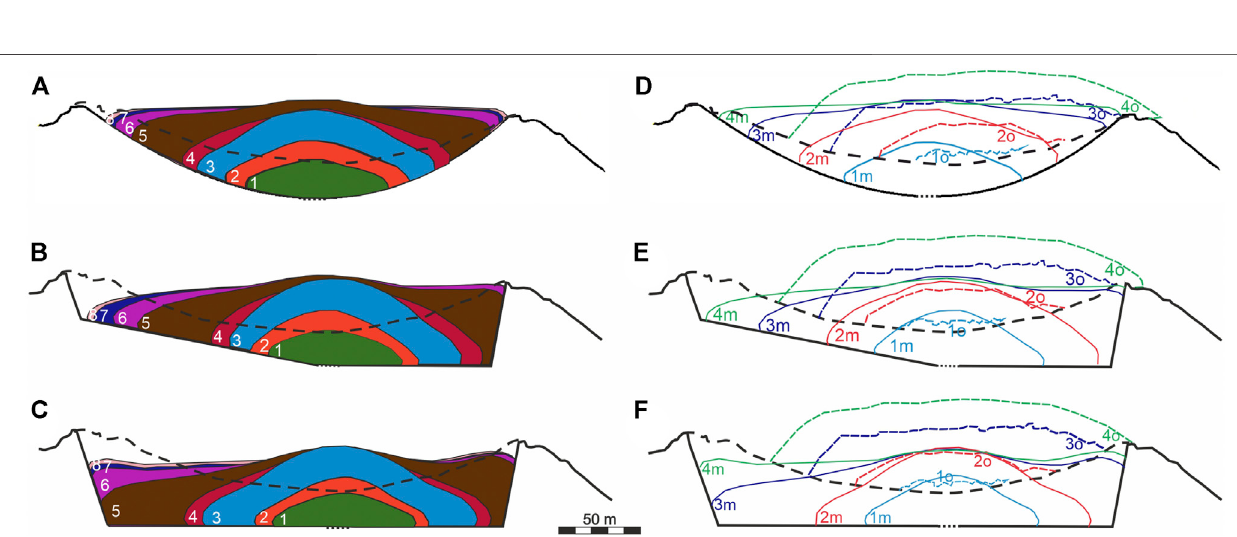
Frontiers in Earth Science |